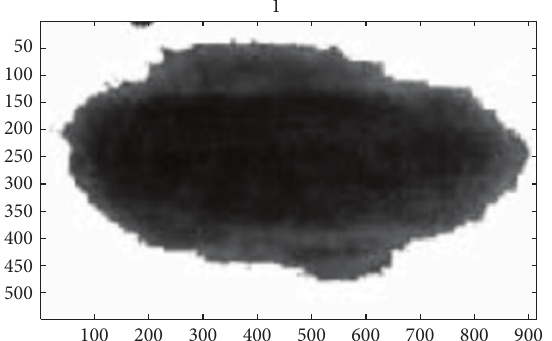
Figure 5: Segmentation result of Gray leaf spot.